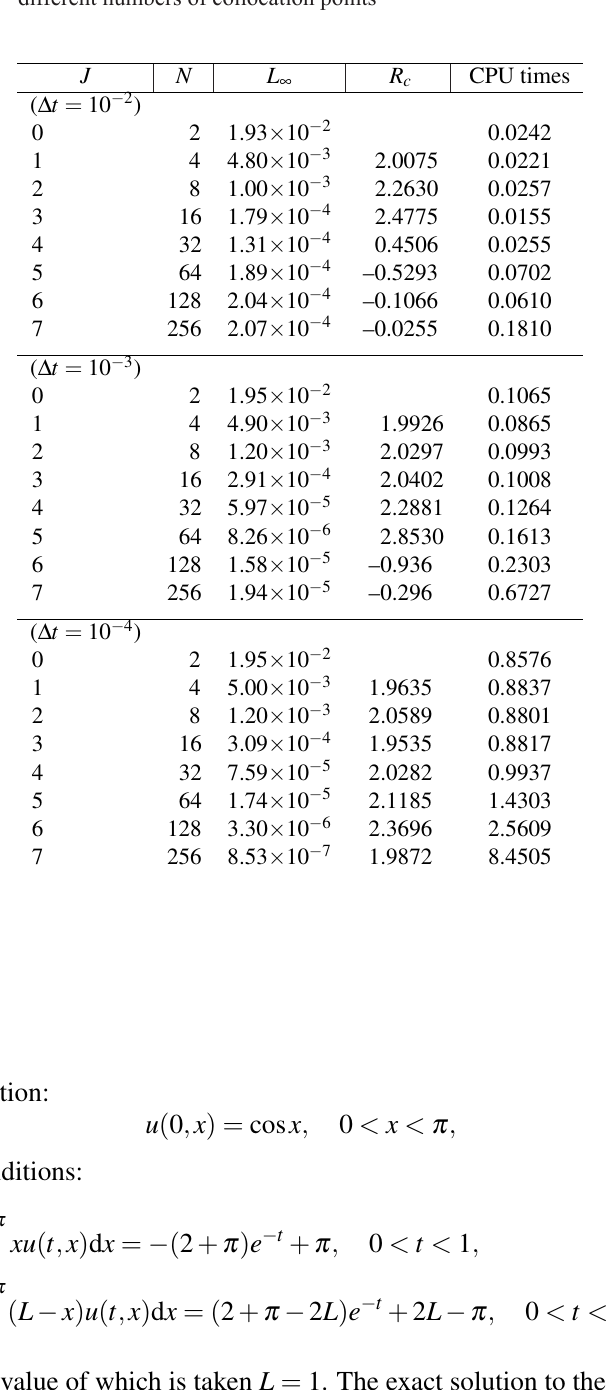
Table 4. Numerical results of Test Problem 5 at t = 1 and at different numbers of collocation points